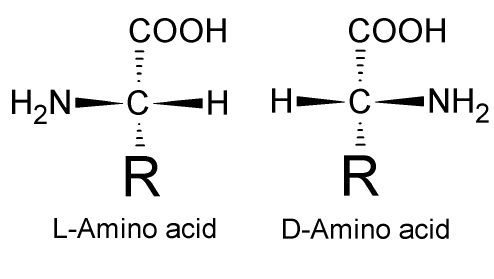
Figure 1. Representation of L - and D -amino acid